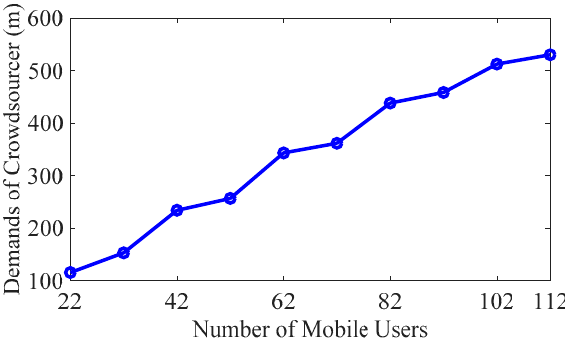
Figure 5. Demands of the crowdsourcer change with the number of mobile users.